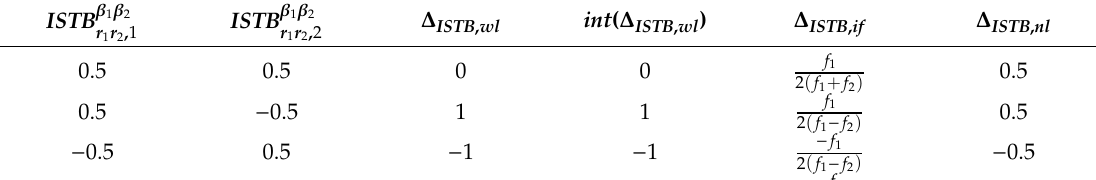
Figure 1. The fractional parts of WL and NL DD ambiguities for GEO and non-GEO satellites at zero- baseline ZIM2-ZIM3.